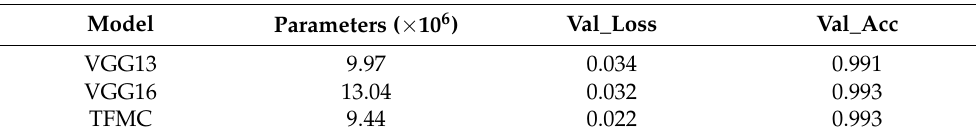
Table 3. Comparison between different networks. Val_Loss and Val_Acc represent the loss and accuracy for the validation dataset, respectively.